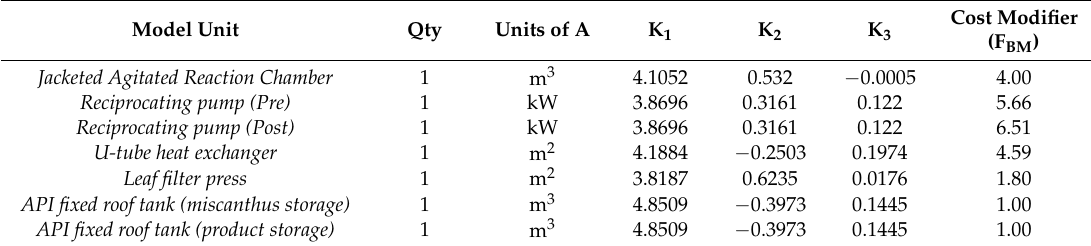
Table 2. Constants used for equipment costs used in process flow